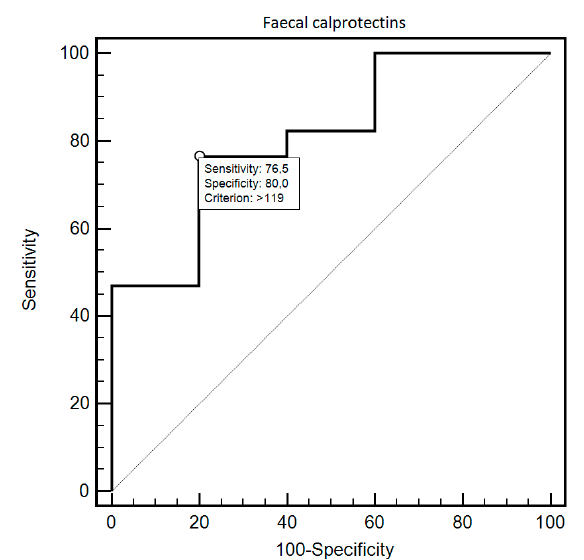
Figure 2. ROC curve illustrating the diagnostic usefulness of fecal calprotectin in SSc detection in individuals with SIBO.